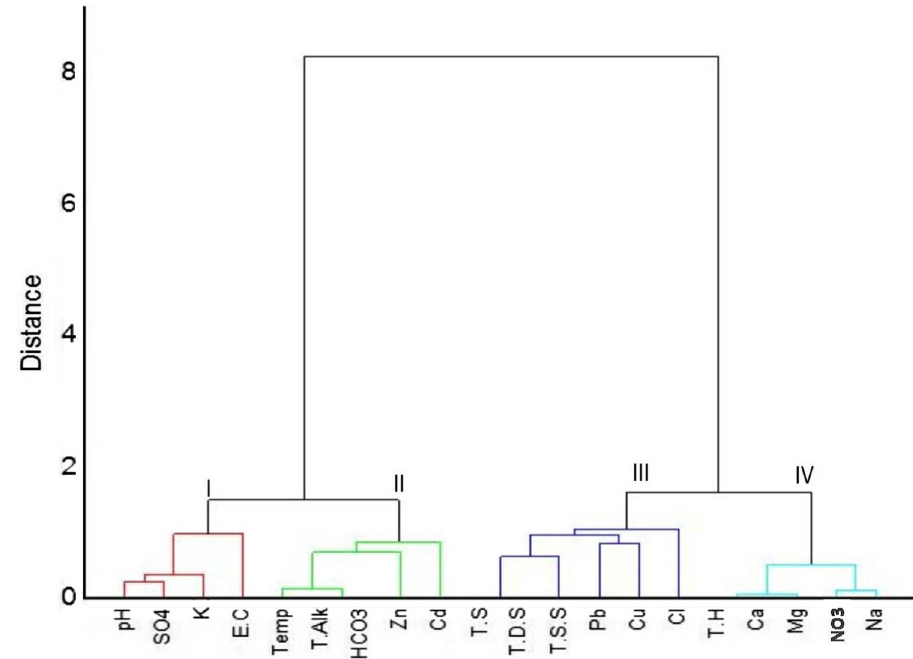
Fig. 4 Hierarchical cluster den- dogram of the physicochemical parameters in the spring